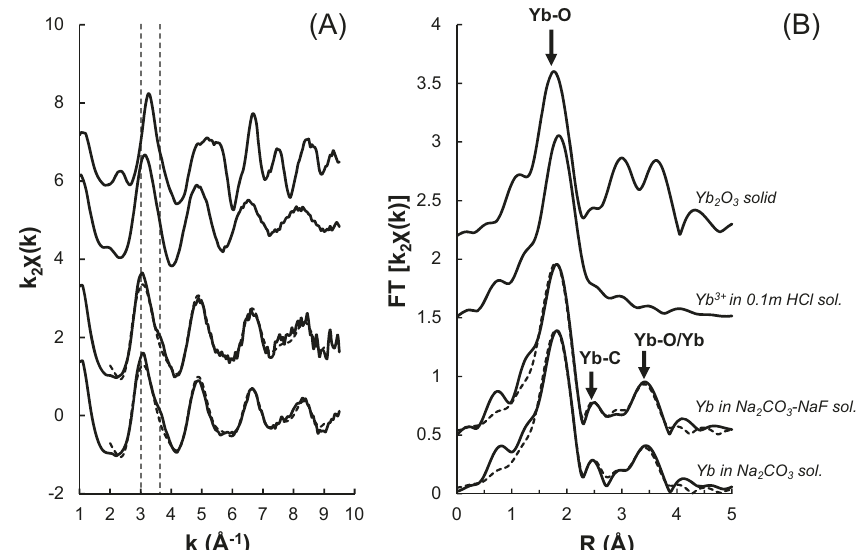
Fig. 3 EXAFS spectrum (A) and corresponding Fourier transform (B) for Yb in Na 2 CO 3 ± NaF solutions at 200 °C and 80 MPa. The spectrum is compared to that of Yb oxide crystalline compound and Yb dissolved in Cl-rich acidic solution. The fi ts are reported as a dashed line over the experimental spectra. The two vertical dashed lines on ( A ) underline differences in the shape and position of the EXAFS oscillations between alkaline and acidic solutions. Bold arrows in ( B ) point to the features arising from different scattering paths to oxygen (Yb – O) and carbon (Yb – C) fi rst neighbor atoms or oxygen and ytterbium atoms in the second shell (Yb –